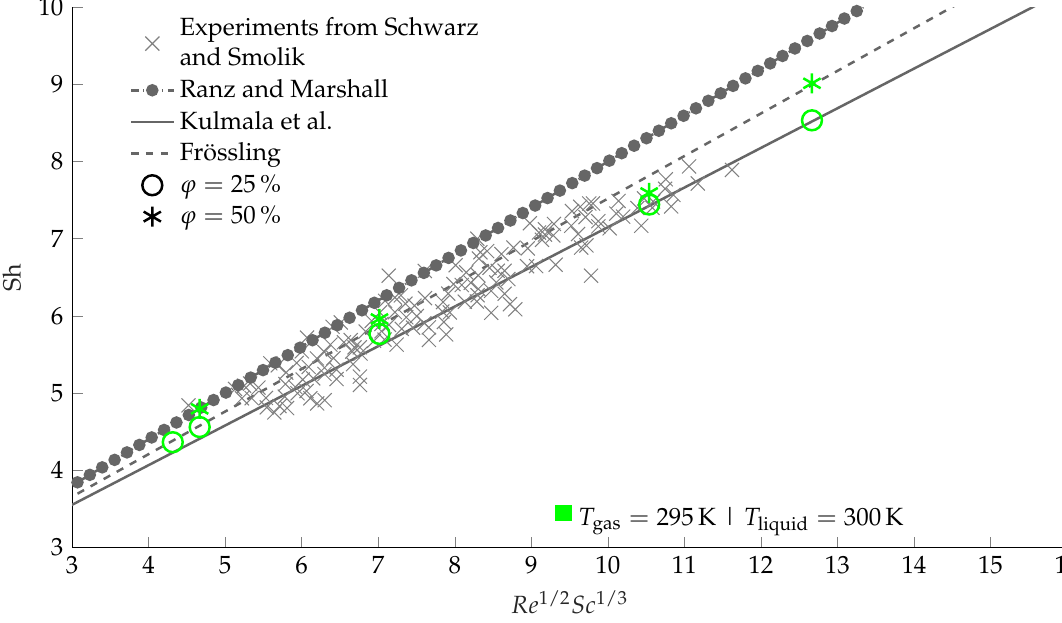
Figure 13. Sh over Re 1/2 Sc 1/3 : Experimental results [21] and correlations from the literature ([5–7]) plotted together with results from simulations with a resolution of 51 cells per